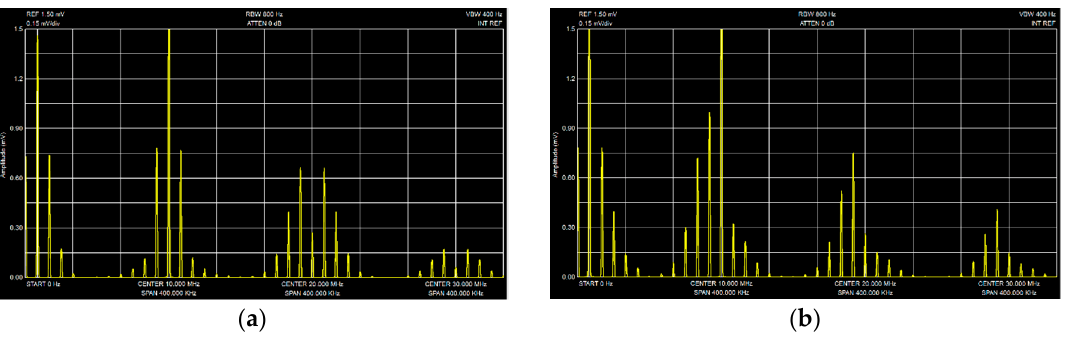
Figure 11. Spectrums of microwave oscillations of the output of the stabilized ( a ) and usual ( b ) (non- stabilized) oscillators. Figure 12. Spectrums of the autodyne signal obtained for the stabilized oscillator in the frequency on the Gunn diode with AM ( a ) and for usual (non-stabilized) oscillator, in which the attended FM is present ( b ).